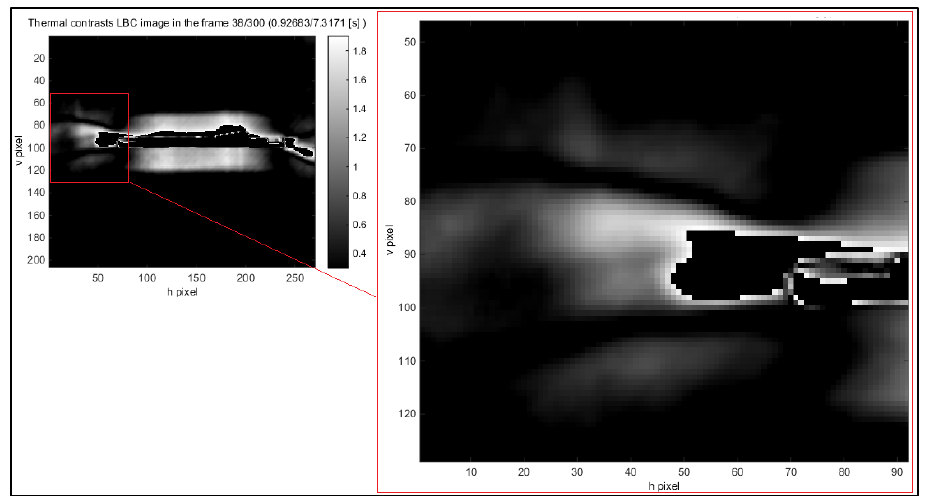
Figure 19. Contrast map of multi-stringer component using heating pulse of 3 s ( a ) and 10 s ( b ).